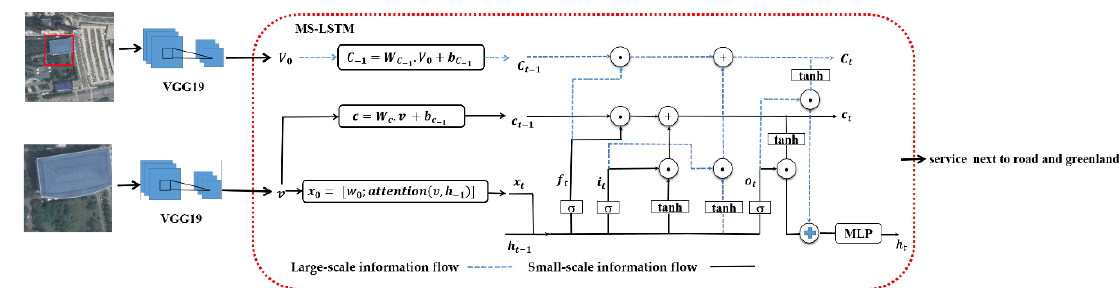
Figure 3. Network structure. It shows the overall network structure of the MS-LSTM. In our network, a small-scale remote sensing image and its corresponding large-scale image are input into two VGG19 networks respectively to extract two scale semantic information. At the output-end, a 1024-dimensional large-scale semantic memory unit and a 1024-dimensional small-scale memory unit are concatenated to form a 2048-dimensional vector, which is input into a MLP. And then the MLP outputs a 1024-dimensional vector, which is activated by tanh and then updates the hidden layer information h t through the output